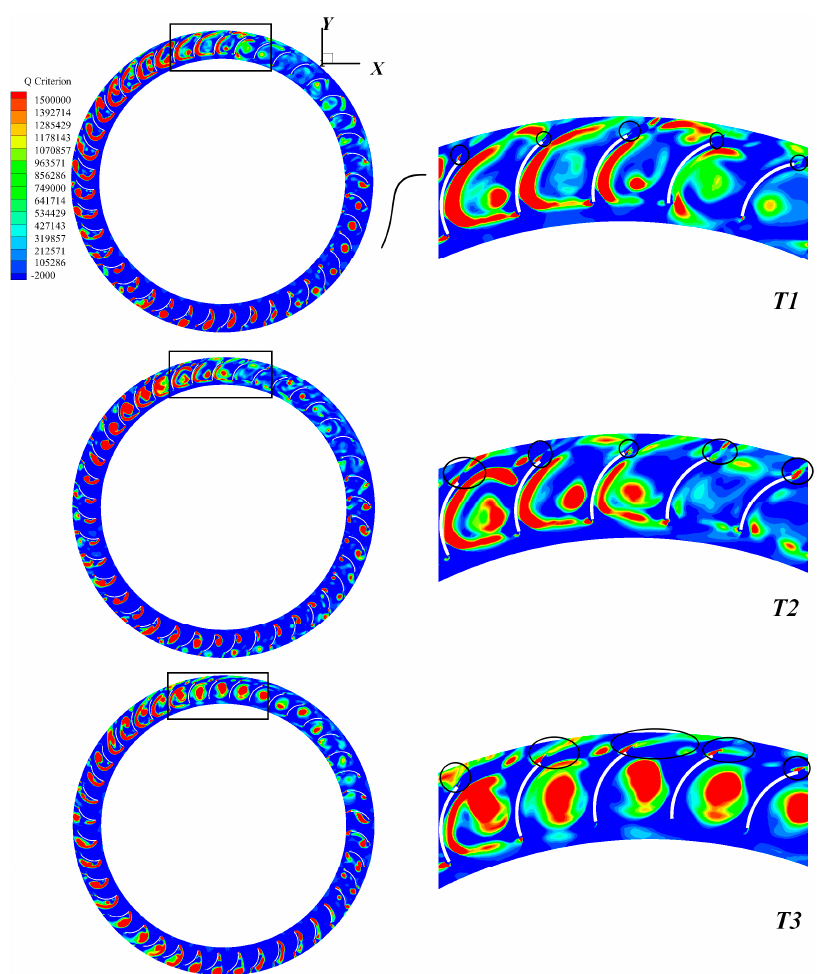
Figure 20. Q value distribution at di ff erent times of blade passage on the Z = 0.015 m section (Q / Qn = 0.031).